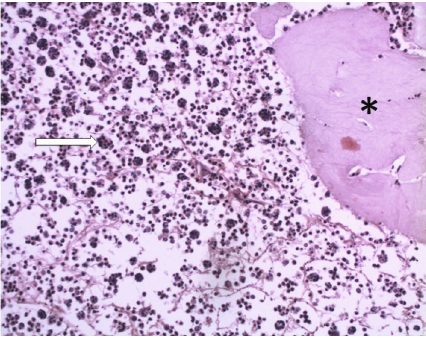
Figure 6: Neutrophil-laden macrophages (arrow) in in fl ammatory response associated with injected gel ( ∗ ). H and E stain ×